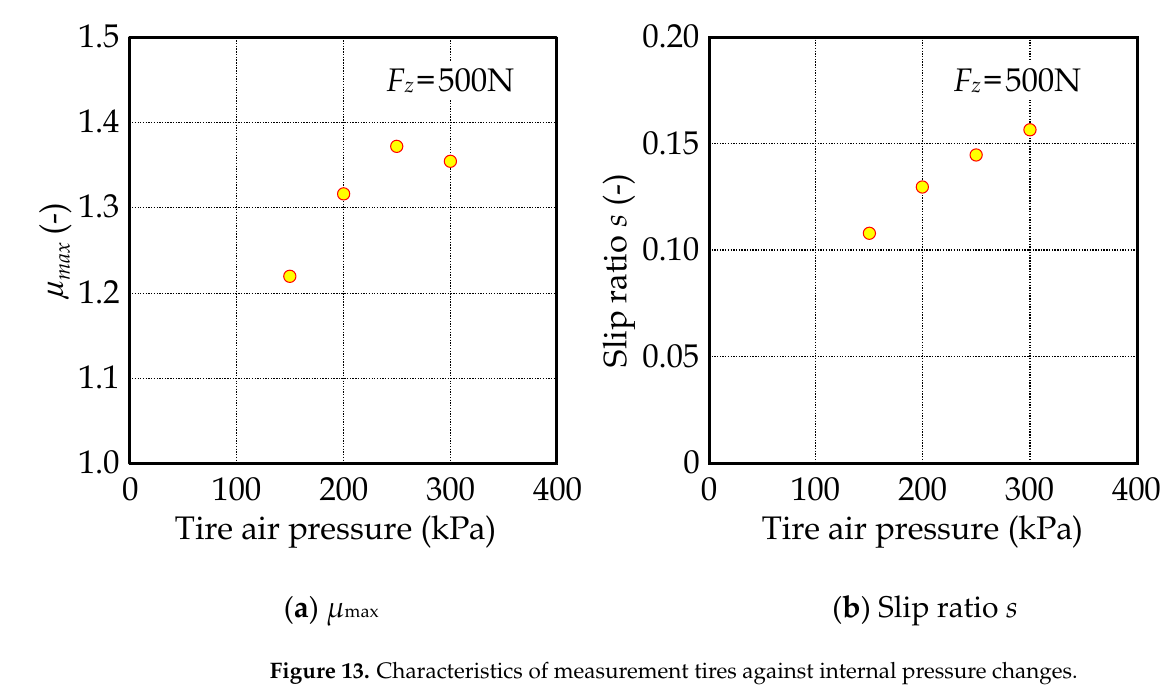
Figure 12. μ -s characteristics against internal pressure changes.